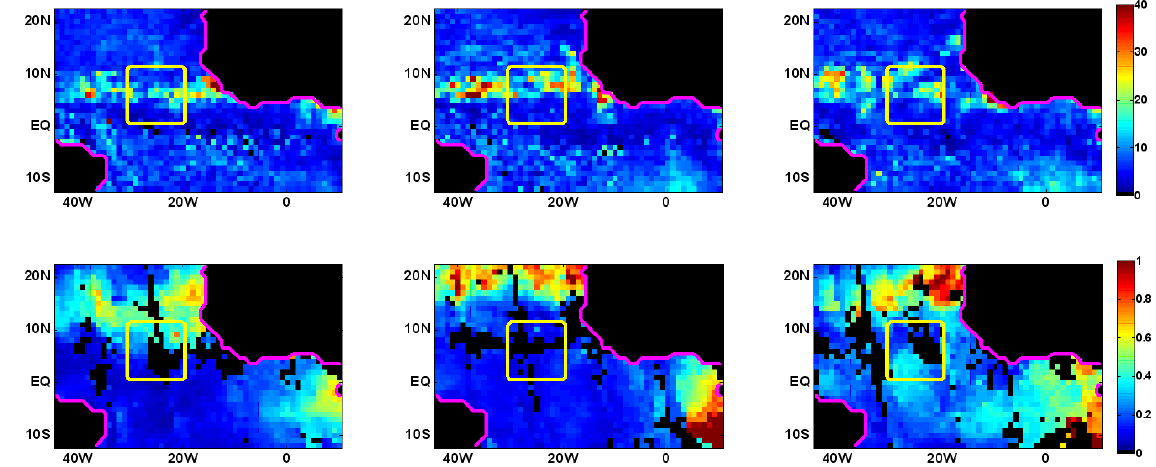
Fig. 1. Three day mean MODIS-derived cloud optical depth (upper) and aerosol optical depth (lower) for the 10 degree box that defines the study area (yellow outline) and for a larger region of the tropical Atlantic for context. Three periods are shown. 1–3 July 2007 (left) showing dust intrusion into the study box from the north. 31 July–2 August 2007 (center) showing overall clean background conditions in the study box and biomass burning aerosol near the African coast at 10 ◦ S. 12–14 August 2007 (right) showing elevated aerosol arriving in the study box from the south and east that originates from the African biomass